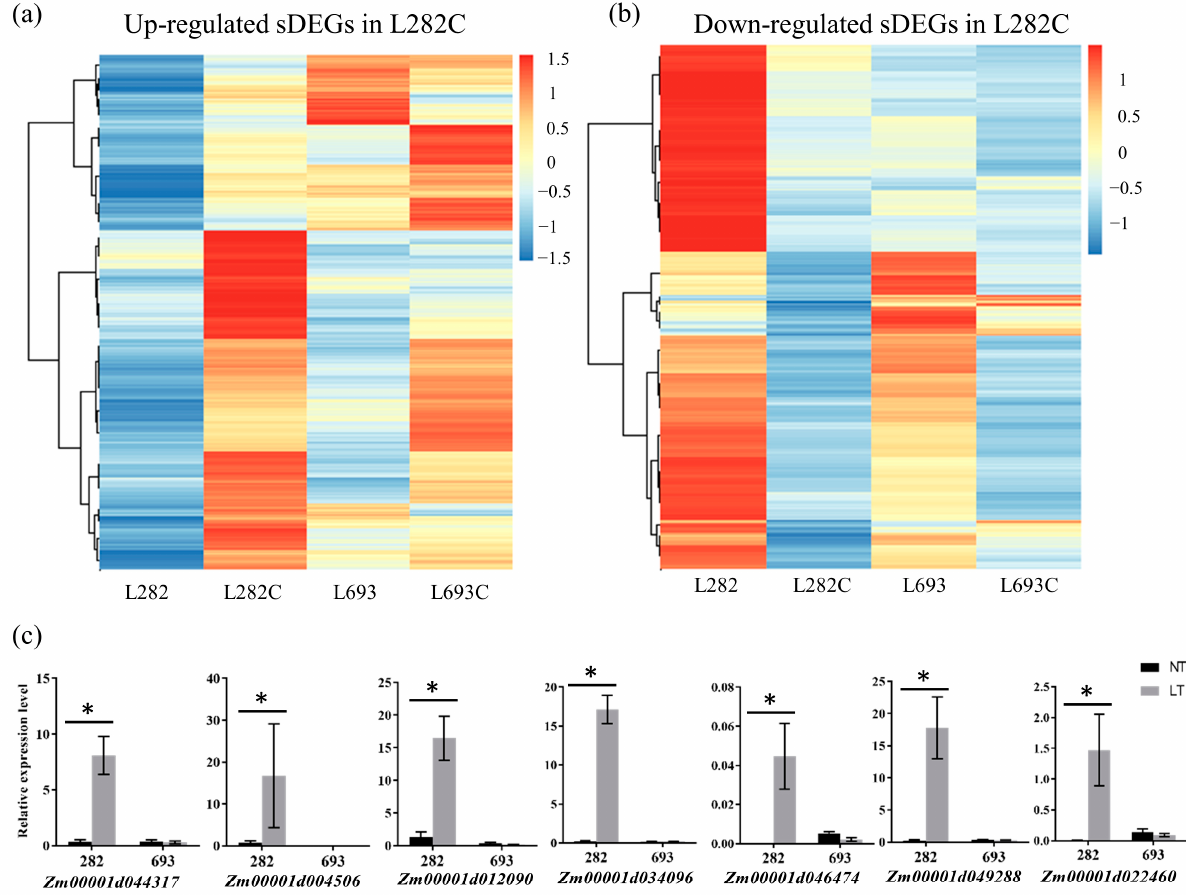
Figure 5. The analysis of L282’s specifically expressed DEGs (sDEGs) in response to low temperature. ( a , b ) Heatmap clustering of the upregulated sDEGs ( a ) and downregulated sDEGs ( b ). Red and blue indicate high and low abundance according to the normalized FPKM, respectively. ( c ) qRT-PCR analysis of seven sDEGs. The asterisks indicate significant difference at p < 0.05 (n = 3). we focused on the sDEGs relating to carbohydrate metabolism and transport (Table 2).